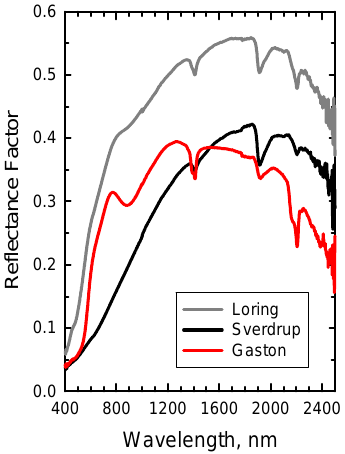
Figure 6 . Reflectance spectra of three diverse soils: Loring (Alfisol), Sverdrup (Mollisol), and Gaston (Ultisol).